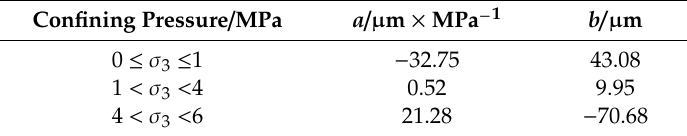
Table 3. Values of parameters a and b in Equation (1).